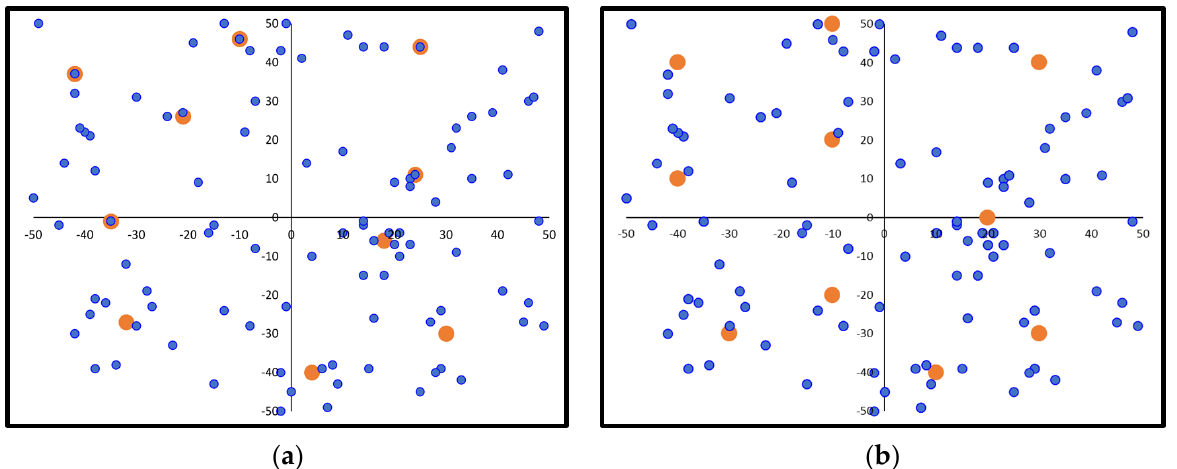
Figure 13. Indicative deployment optimization results of a 10-station network for different grid discretization: ( a ) 1 unit discretization; ( b ) 10 units discretization (demand points in blue color, charging stations in orange color).